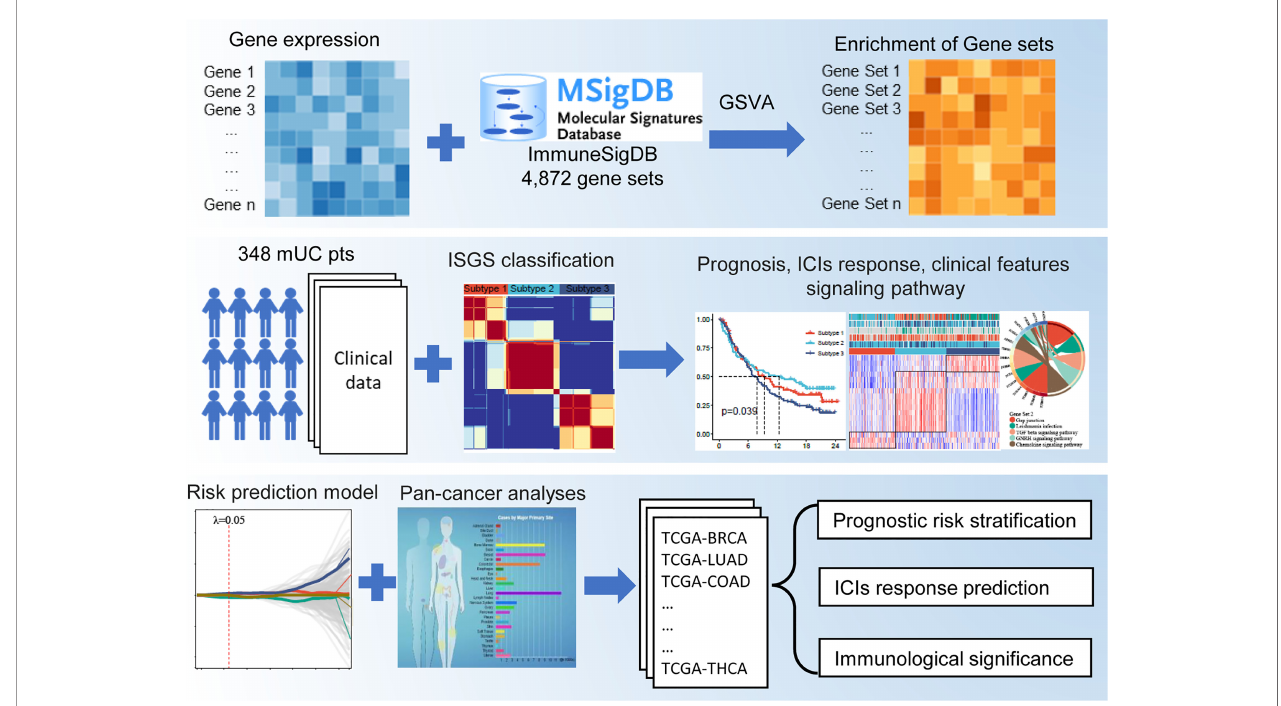
FIGURE 1 | Graphic abstract of this